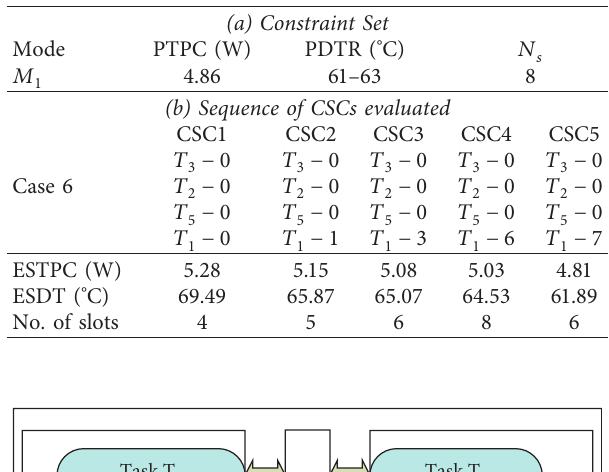
Figure 15: Selected system configuration for RTSA using Explorer for case Table 10: Constraint Set and CSCs evaluated for case 6.